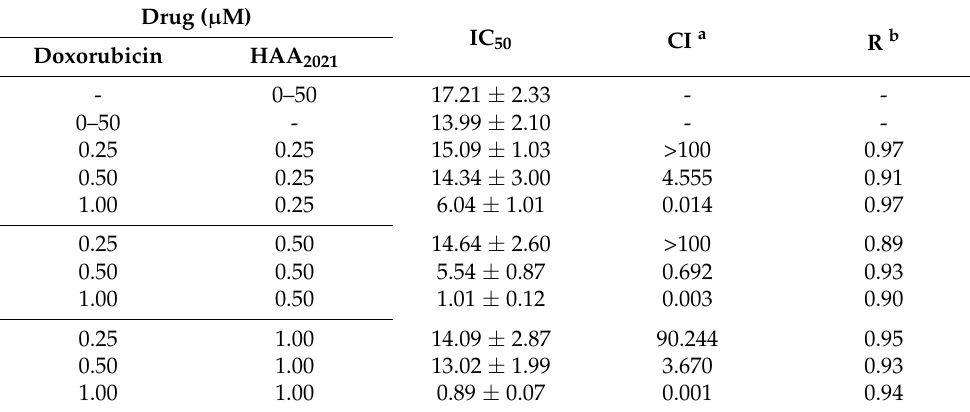
Table 2. IC 50 ( µ M) and combination index of MCF7/ADR cells treated (72 h) with different concen- trations of doxorubicin and HAA 2021